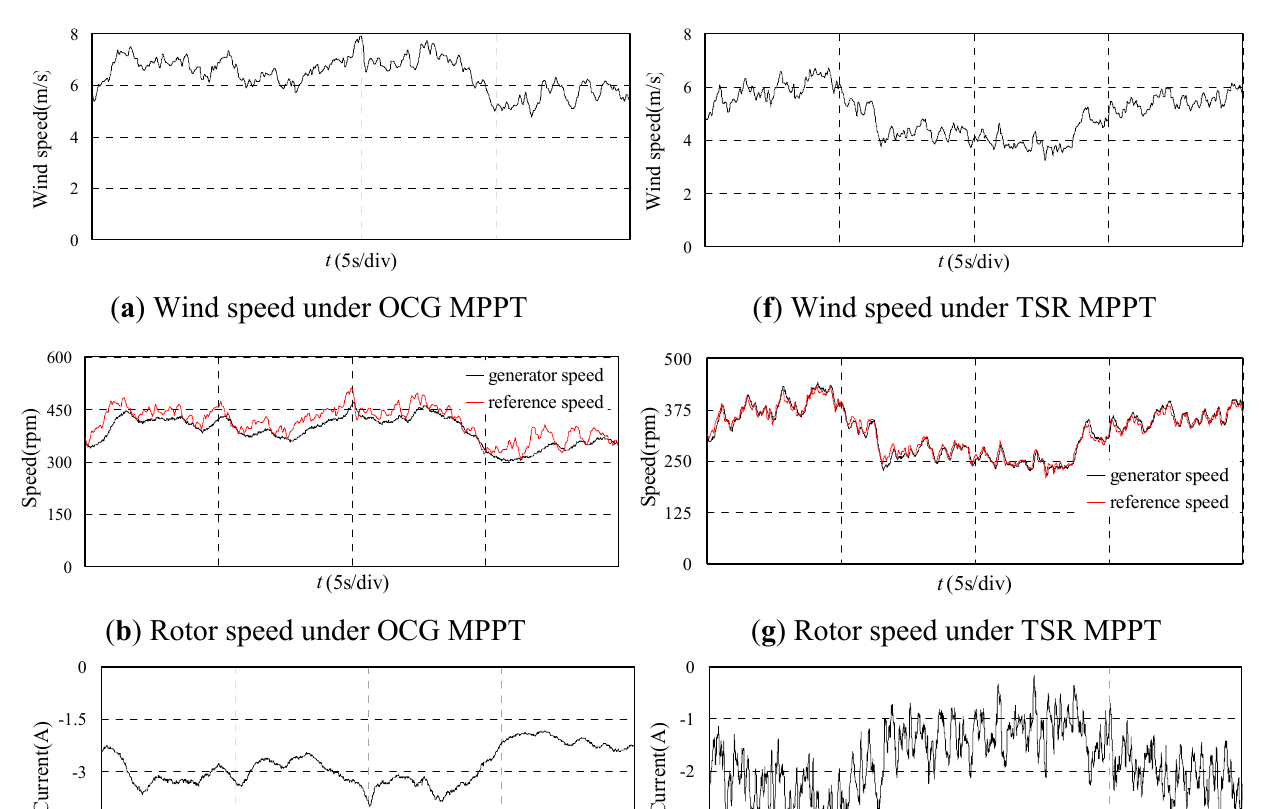
Figure 11. Experimental waveforms of PMSG with proposed OCG MPPT and TSR